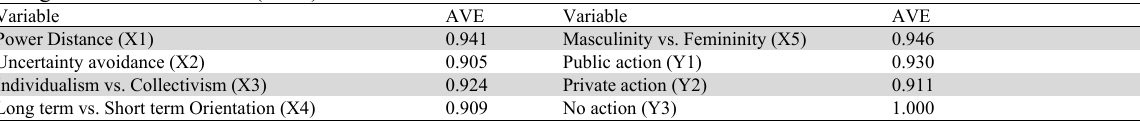
Average Variance Extracted (AVE)